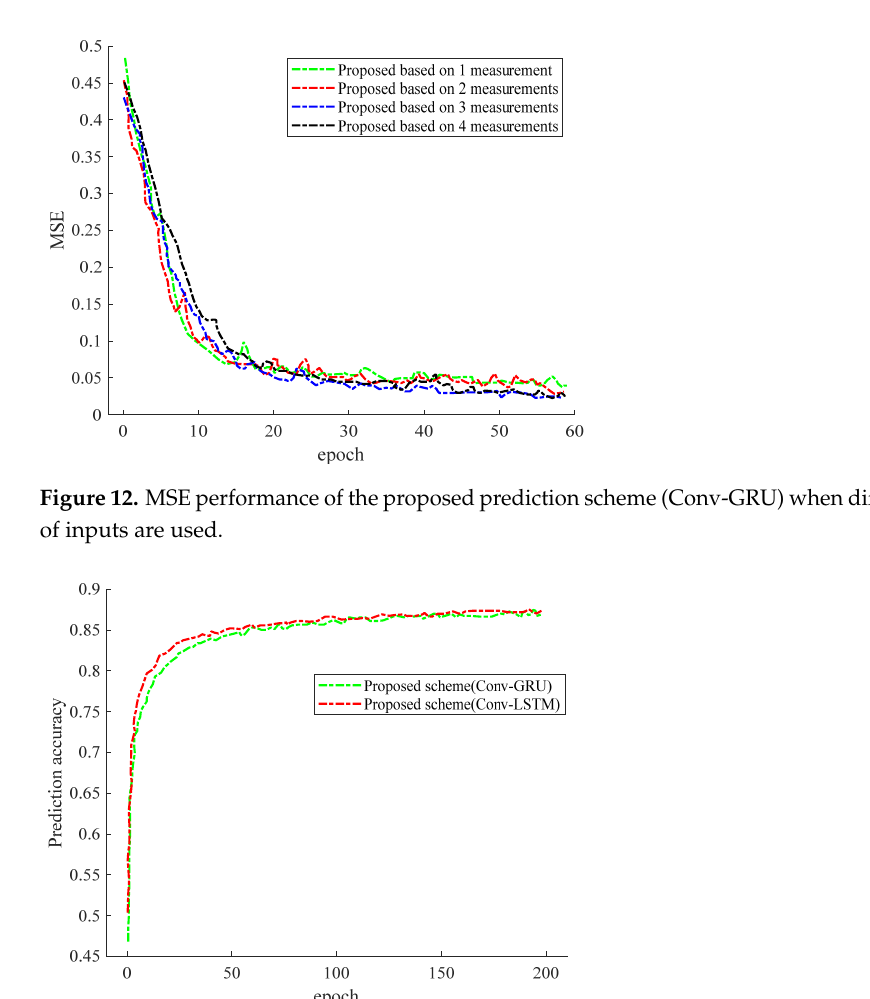
Figure 11. MSE performance of the proposed scheme (Conv-LSTM) when different numbers of in- puts are used.